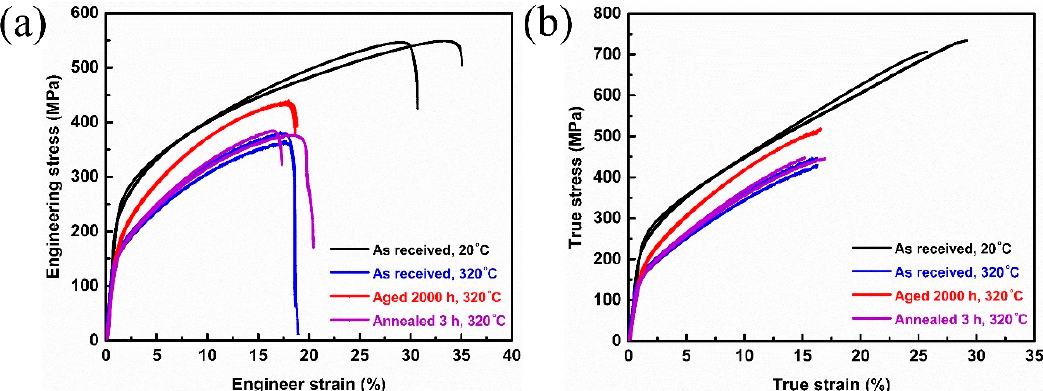
Figure 4. Stress-strain curves of Z3CN20-09M stainless steel with different aging conditions: ( a ) engineering stress–strain curves and ( b ) the corresponding true stress–strain curves. Here the “as received, 20 °C” represents the as received specimens condition tested at 20 °C; the “as received, 320 °C” represents the as received specimens condition tested at 320 °C; “aged 2000 h, 320 °C” represents the aged at 475 °C for 2000 h condition tested at 320 °C and “annealed 3 h, 320 °C” represents the aged at 475 °C for 2000 h then annealed at 550 °C for 3 h condition tested at 320 °C.